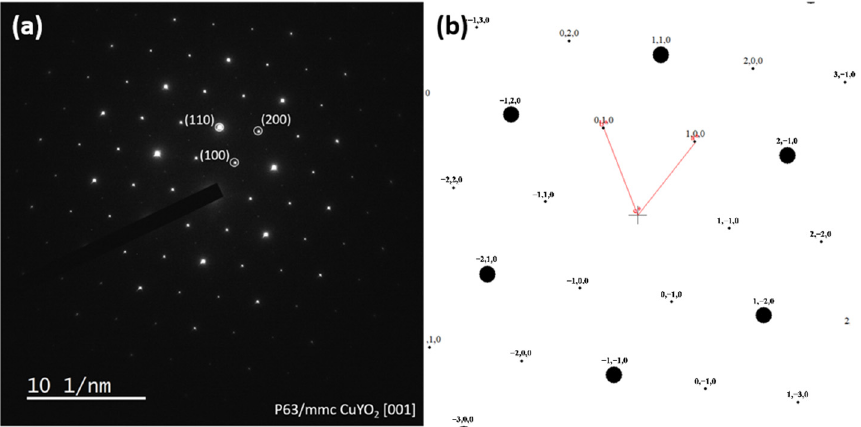
Figure 9. ( a ) SAED pattern of P63/mmc CuYO 2 nanofibers, ( b ) simulated diffraction pattern of P63/mmc CuYO 2 .